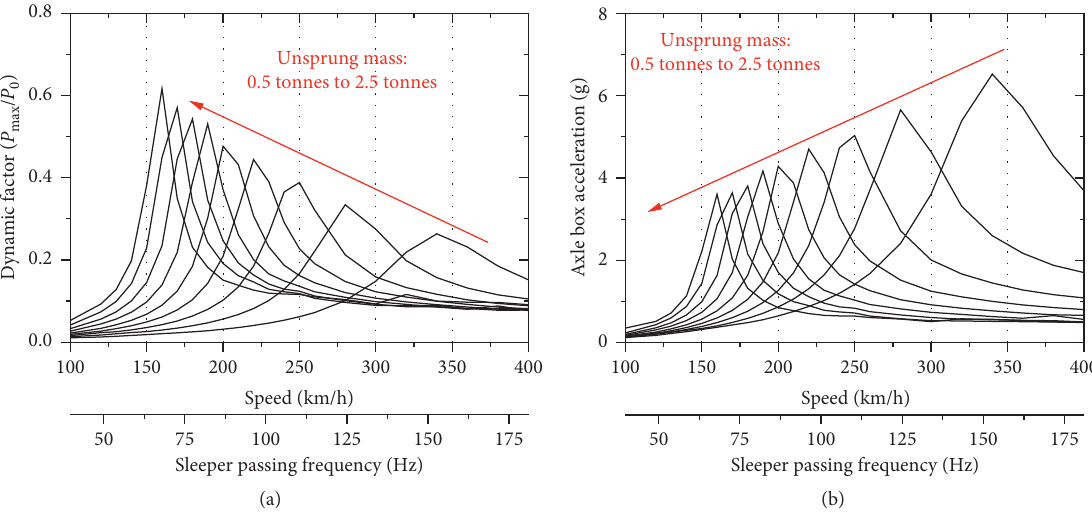
Figure 14: Effects of the unsprung mass on the sleeper passing impact: (a) dynamic factors; (b) axle box accelerations.